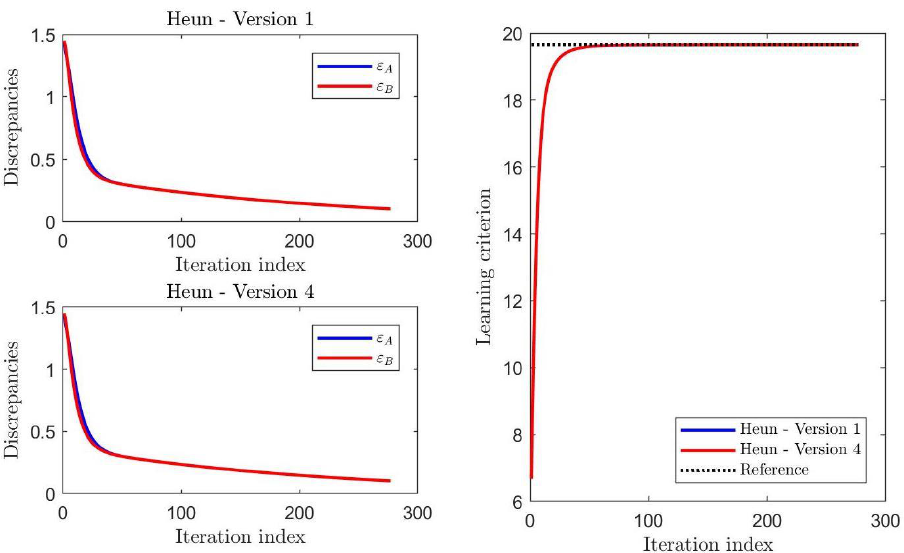
Figure 1. Results of a comparison of the values taken by the performance indexes during learning by the Heun method in its Versions 1 and